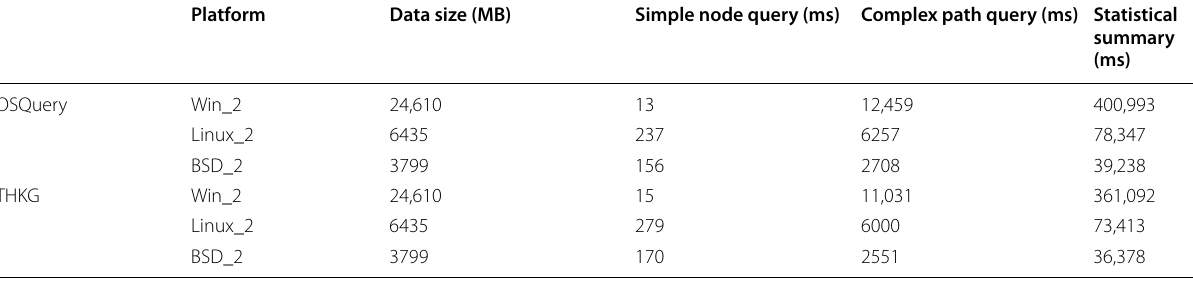
Table 9 Query delay of different complexity by OSQuery and THKG